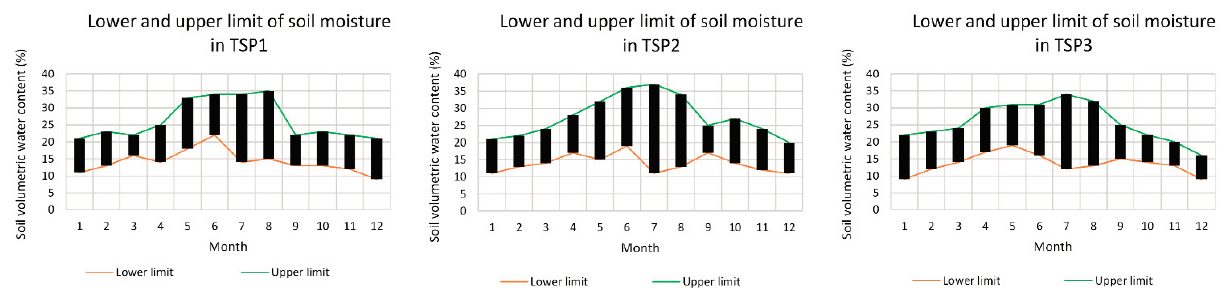
Figure 9. Variation range of every TSP for every month.